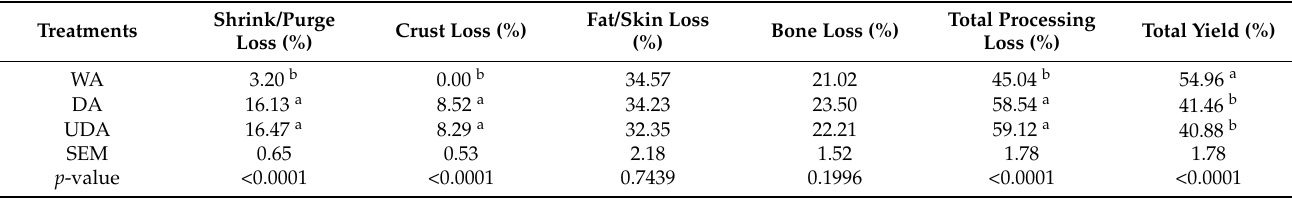
a,b Different superscript letters indicated a significant difference between the different aging methods ( p < 0.05). Different aging treatments: wet-aging (WA), conventional dry-aging (DA) and UV-light dry-aging (UDA). SEM: standard error of